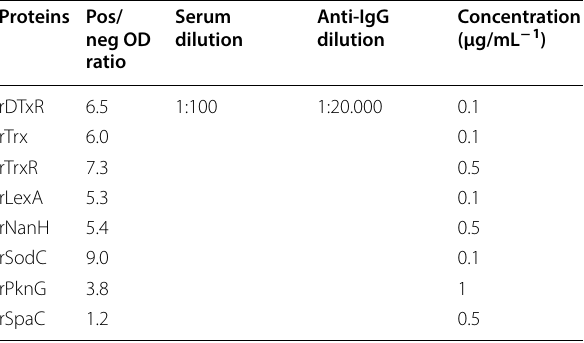
Table 2 Cut-off values, sensitivity, and specificity of C.